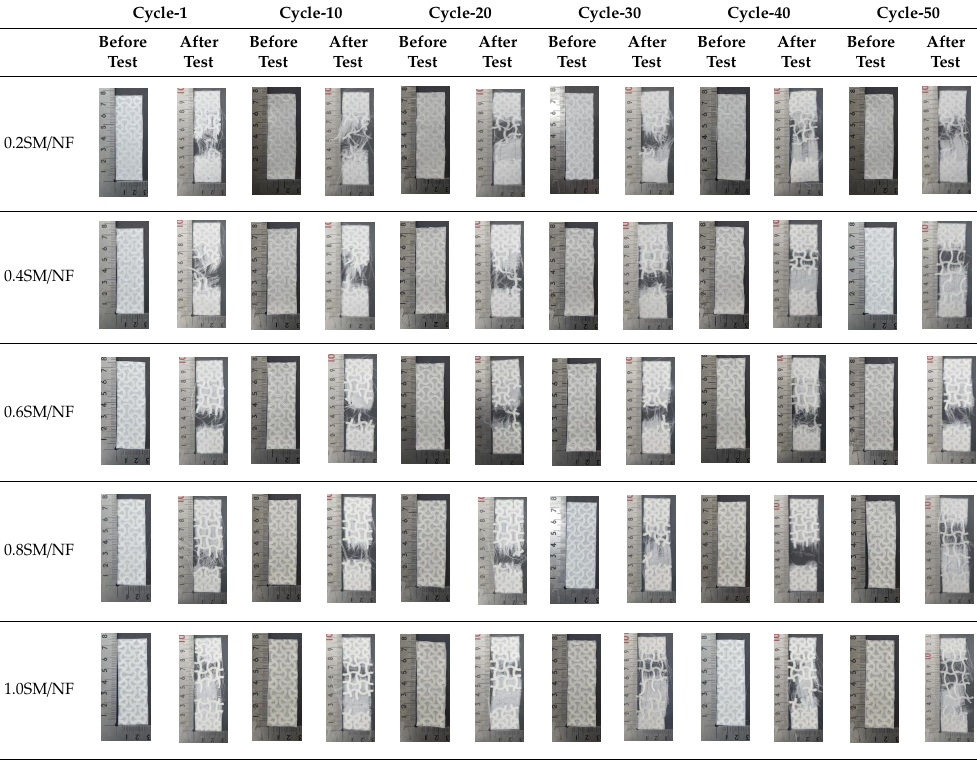
Table 4 summarized the tensile property based on the stress-strain curve of a 3D-printed sinusoidal sample/nylon composite with various thicknesses and various cycles for 50 cycles. The result showed that, for each sample, i.e., 0.2SM/NF, 0.4SM/NF, 0.6SM/NF, 0.8SM/NF, and 1.0SM/NF, the stress gradually increased with some fluctuation from cycle-1 to cycle-50. For 0.2SM/NF, stress